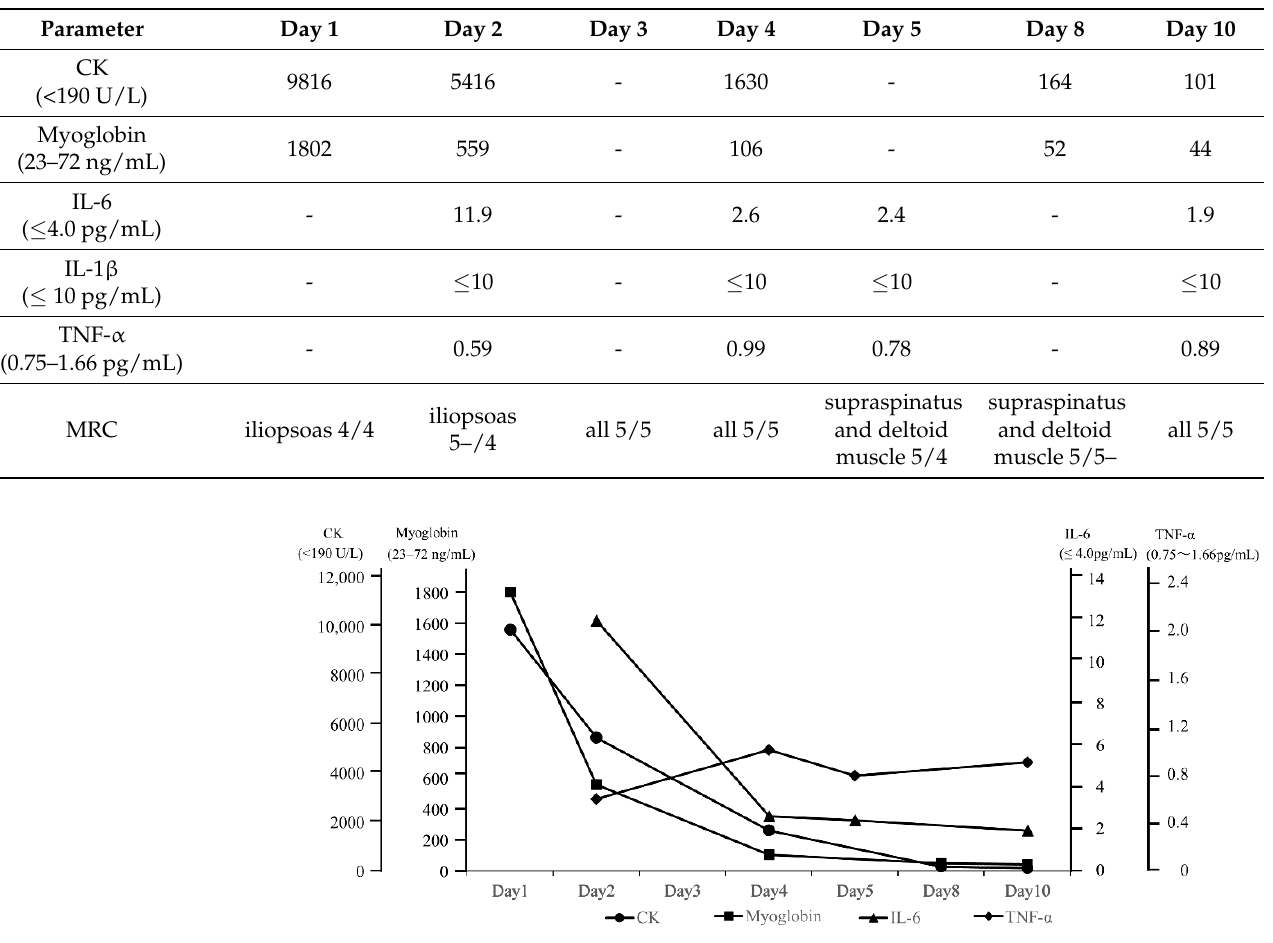
Table 1. Course of laboratory findings and MRC scale.